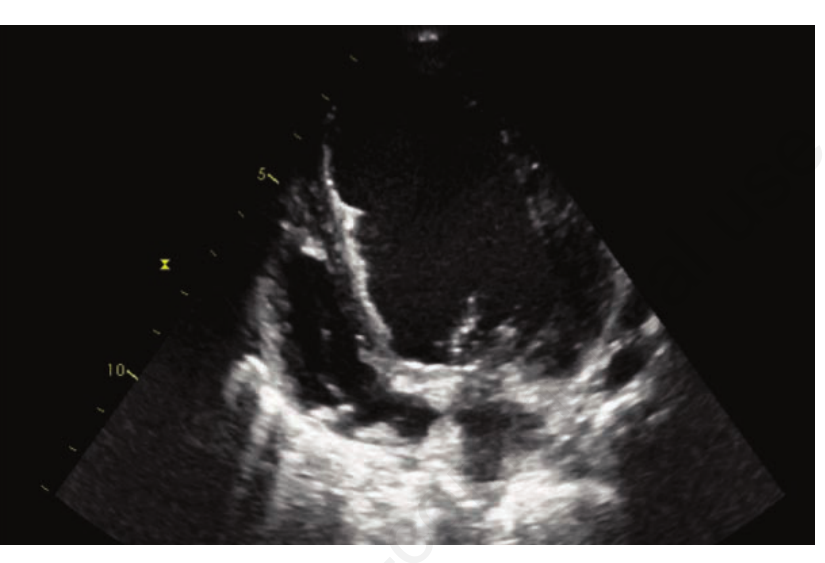
Figure 1. Severe aortic stenosis showed in parasternal short axis view.